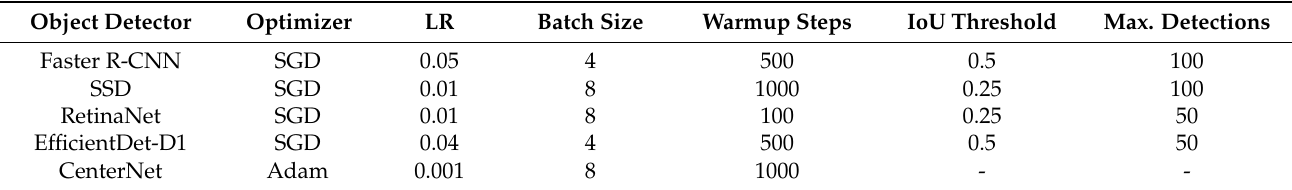
Table 3. Hyper-parameters selected for the final